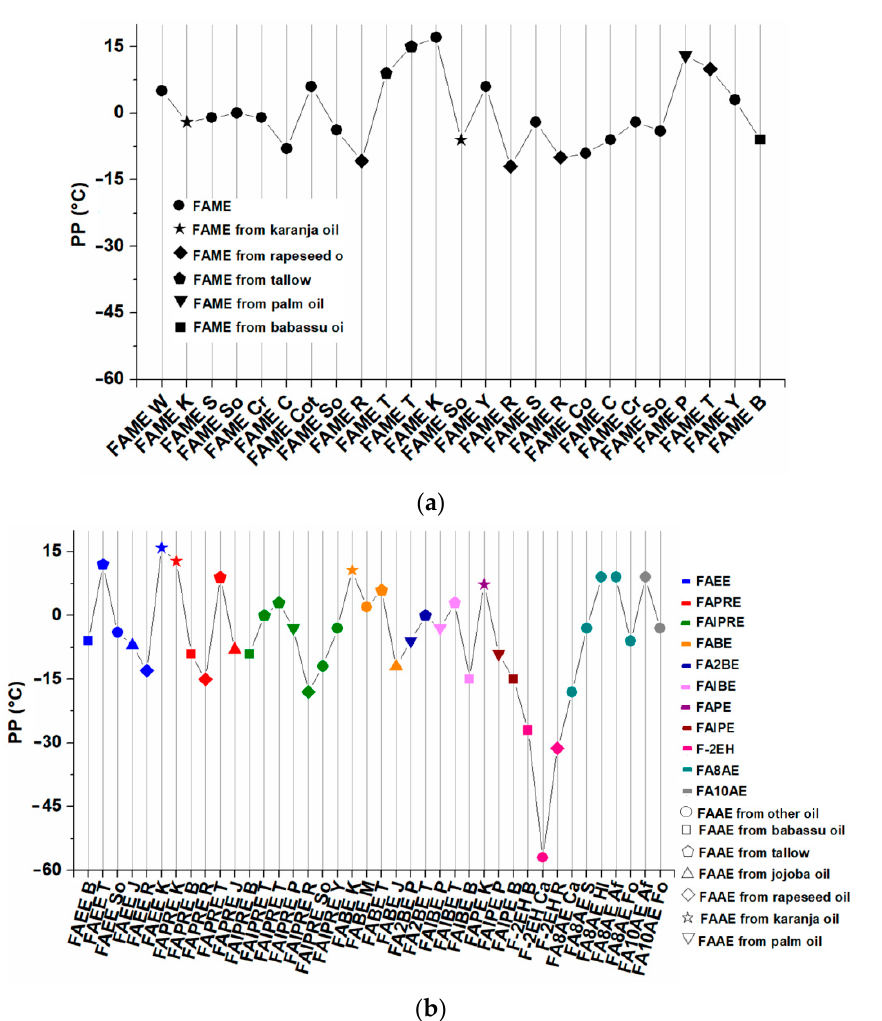
Figure 2. Literature kinematic viscosities of different fatty acid alkyl esters: ( a ) FAME from different triglyceride sources, ( b ) fatty acid alkyl (C 2+ ) esters from different triglyceride sources (values and corresponding references are given in Table 2).